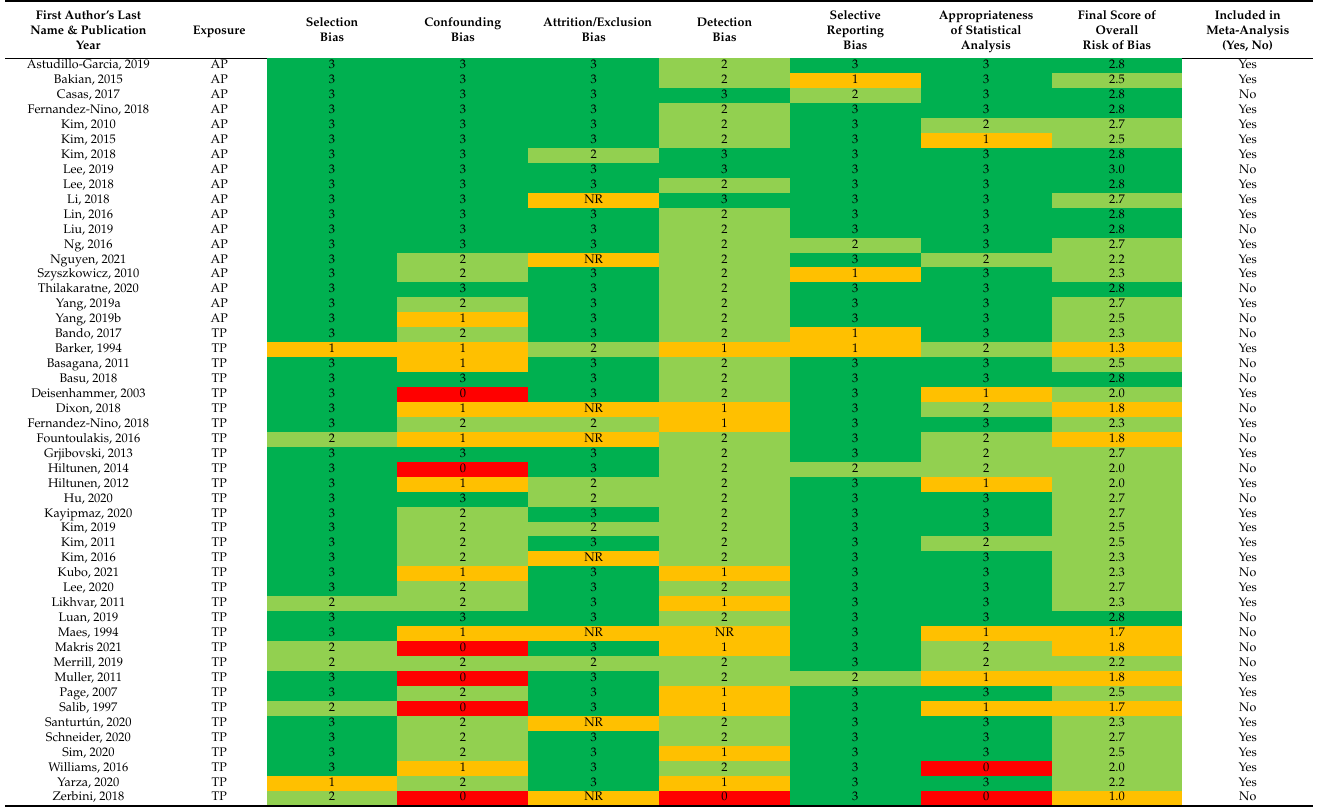
Table 6. Summary of risk of bias for each study.